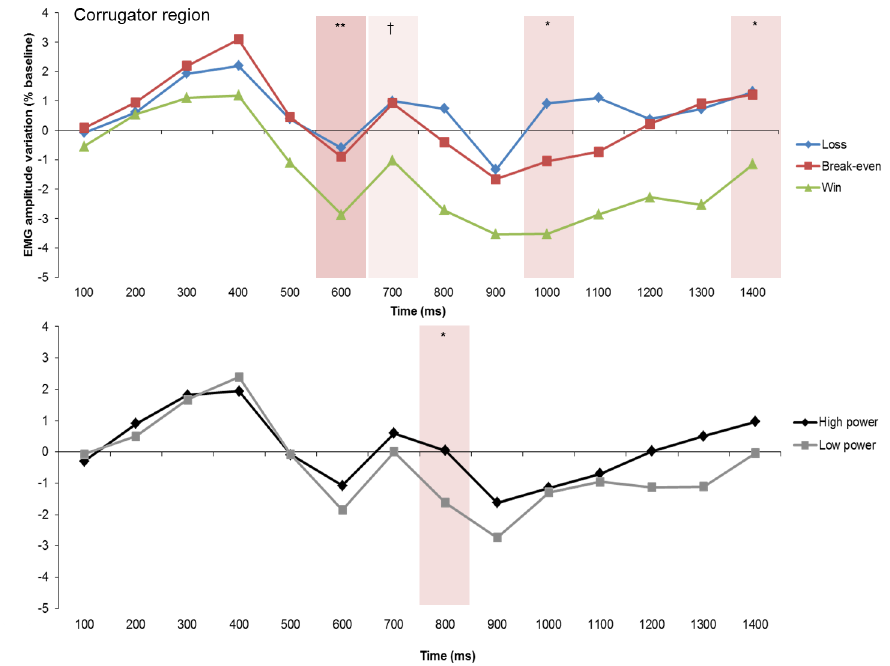
Fig 4. Electromyographic (EMG) amplitude variations (expressed as % change scores relative to baseline) over the corrugator region, showing the goal conduciveness and the power effects across time. † p < .10, * p < .05, ** p < .01.